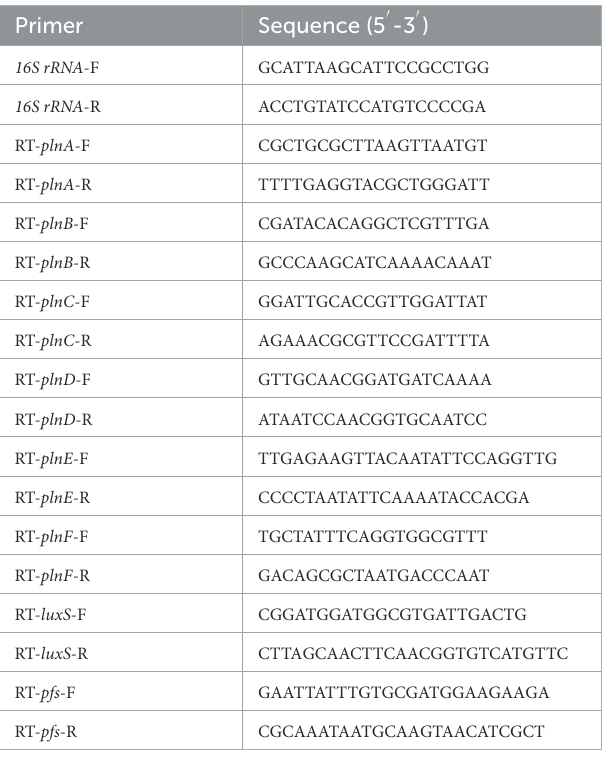
TABLE 1 Primer sequences used for